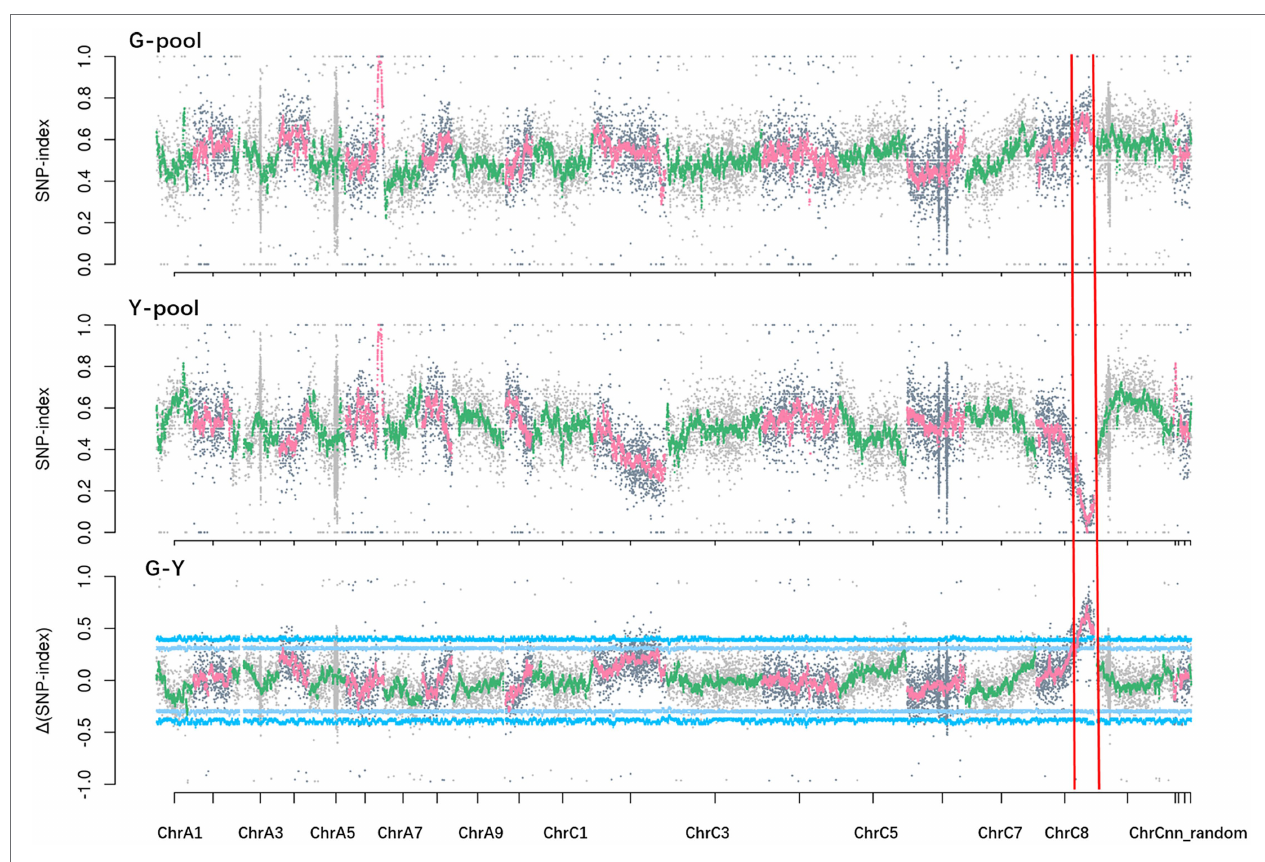
FIGURE 4 | SNP-index (G-pool, Y-pool) and Δ (SNP-index; G-Y) graphs from the BSA-seq analysis. The x axes represent the Brassica napus chromosomes, and the y axes represent the SNP-index or Δ